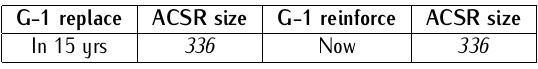
Table 3. Planning of Group-1 feeders with 2% peak growth